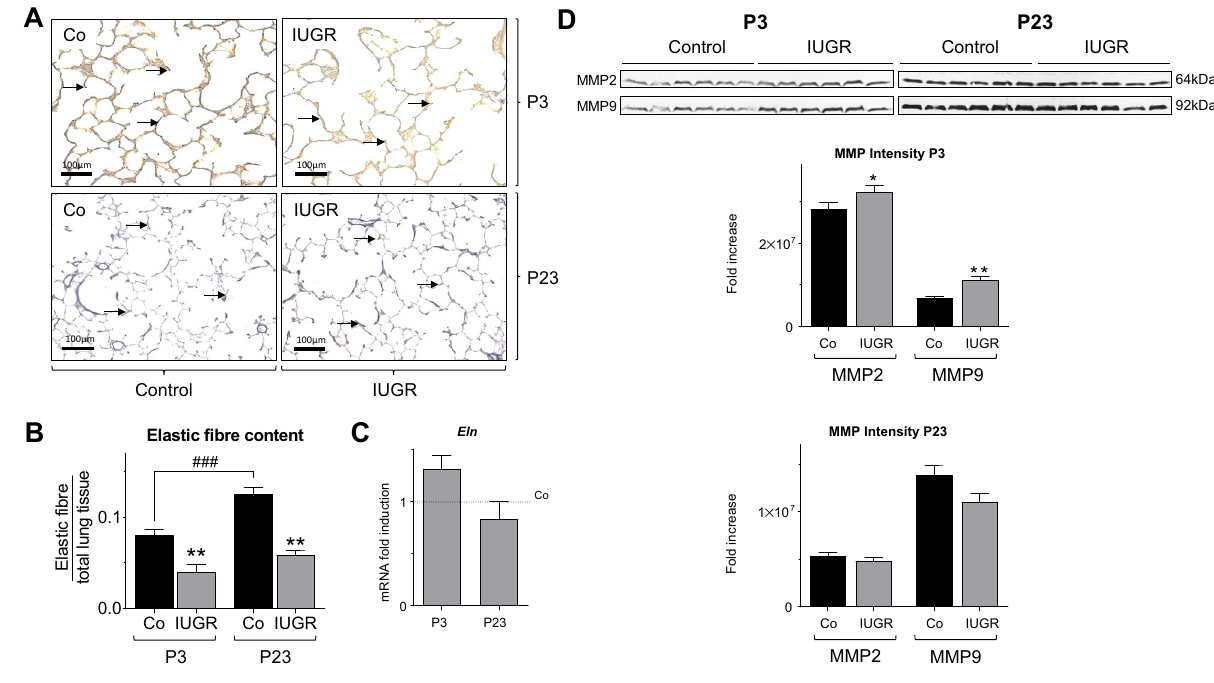
Figure 6. IUGR activates lung proteolytic activity and reduces lung elastic fibre content. ( A ) Representative images (20x magnification) of Hart stained lung at postnatal day 3 (P3) and P23, depicting elastic fibres as indicated with black arrows. ( B ) The quantification of elastic fibre content, relative to total lung tissue at P3 and P23 (n = 6/group). ( C ) Measurement of Elastin ( Eln ) mRNA expression on P3 and P23 using qRT-PCR analysis; Glyceraldehyde 3-phosphate dehydrogenase ( Gapdh ) served as housekeeping gene; the Control group was set at 1 (n = 10/group). ( D ) Analysis of the proteolytic activity of matrix metalloprotease 2 and 9 (MMP2, MMP9) at P3 and P23 using zymography. Both MMP2 and MMP9 are regulators of matrix remodelling; the densitometric quantification of the zymography is shown below (n = 6/group). Mean ± SEM. A non-parametric T-test was used to compare IUGR to the control group, *p<0.05, **p < 0.01. Comparison between P3 and P23 with a two-way ANOVA test, ### p <